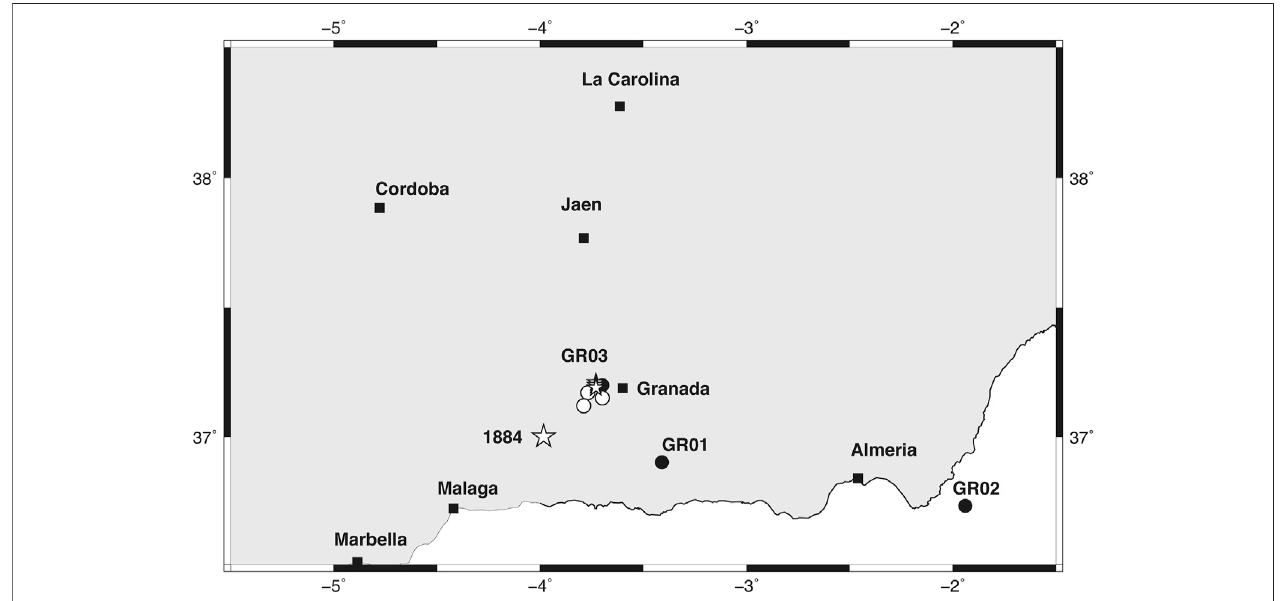
FIGURE 5 | The Granada 2020 – 21 swarm. Black circles show the fi rst PRESTo estimation, white circles show the fi nal estimation, and white stars represent the IGN-derived epicenters and the 1884 epicenter (I max (cid:1) IX-X).